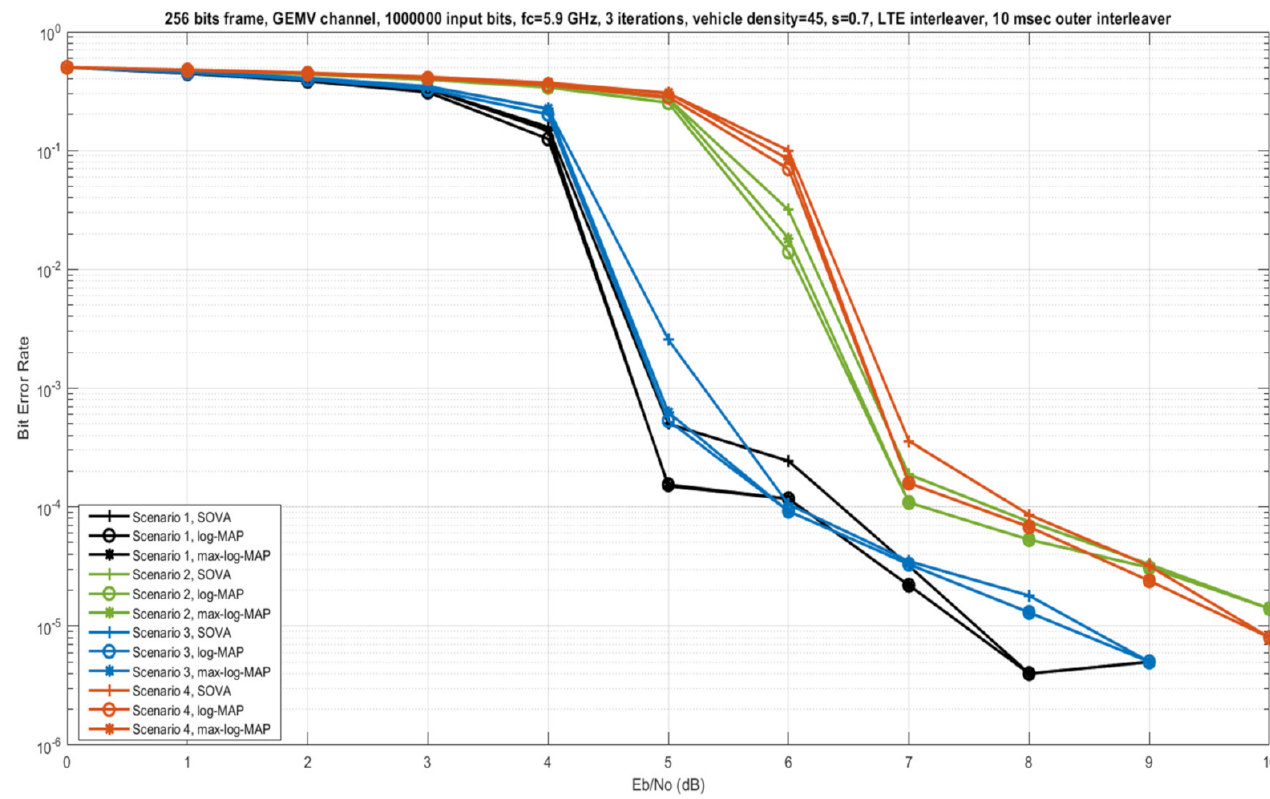
Figure 2. BER vs. SNR for GEMV channel, 4 different Table 2 scenarios, different decoding algorithms, 3 iterations, frame length of 256